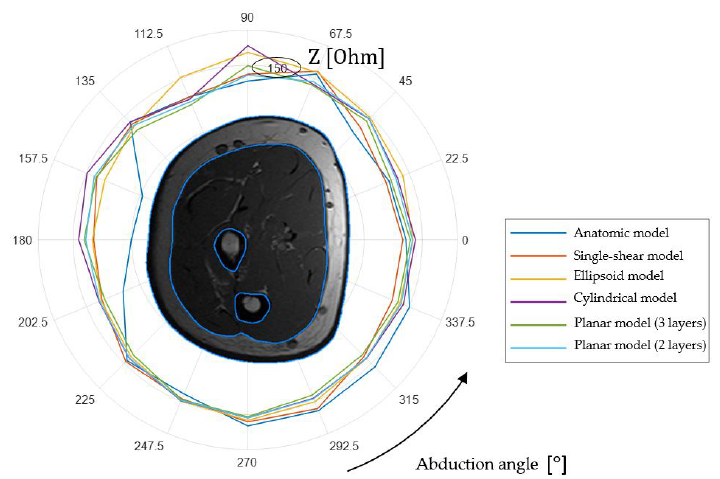
Figure 7. EI simulation results for anatomical and simplified models (Z is an absolute EI value).